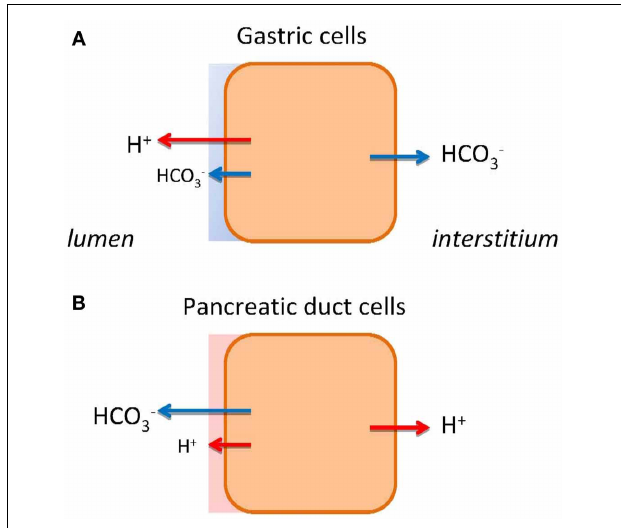
FIGURE 1 | HCO − 3 and H + transport in gastric cells (A) and pancreatic duct cells (B). The models show schematically different types of epithelia as single cells. The transport of H + or HCO − 3 to the bulk luminal fluid is shown with large arrows. The small arrows on luminal side indicate HCO − 3 and H + secretions to the mucosal buffer zone. Flux of HCO − 3 and H + to the interstititum/blood side indicates expected alkaline or acid tides.